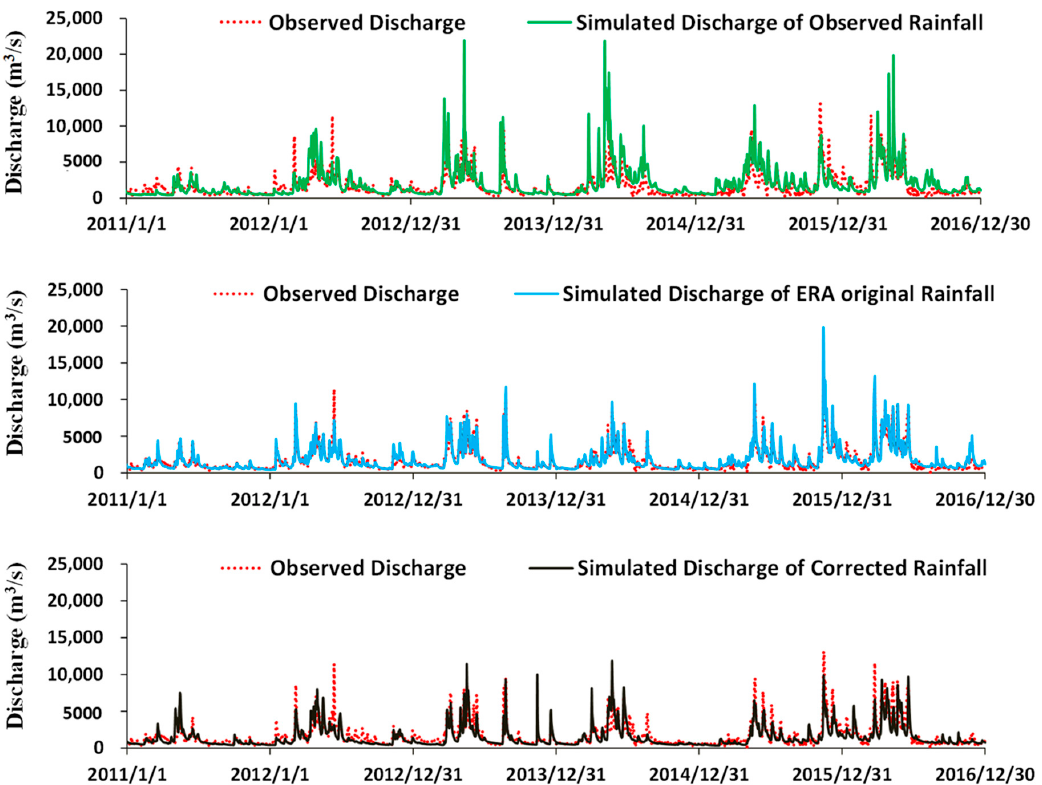
Figure 8. Comparison of the hydrographs at Hengshan station among the observation (reference), observed precipitation-driven simulation, ERA-interim precipitation-driven simulation, and corrected precipitation-driven simulation.